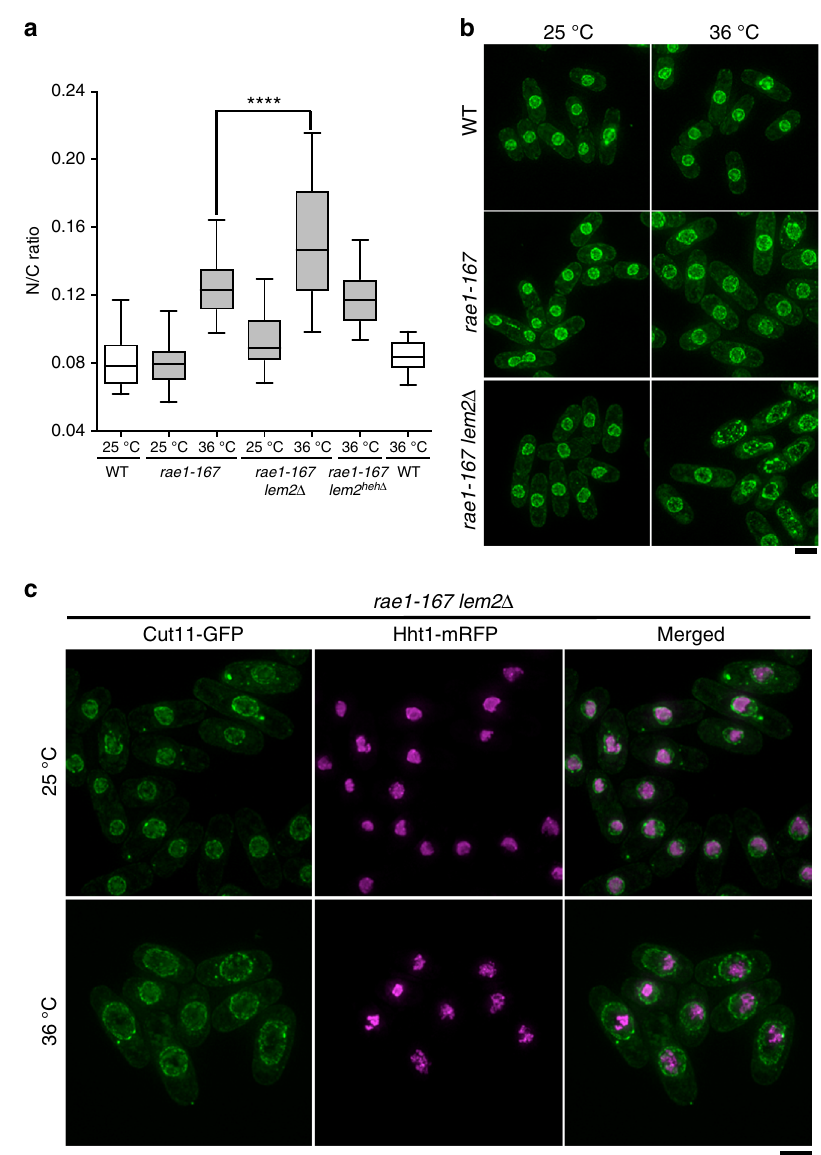
Fig. 1 Lem2 restricts nuclear size enlargement independently of its chromatin-binding activity. a N/C ratio of wild type (WT), rae1-167 , rae1-167 lem2 Δ , and rae1-167 lem2 heh Δ cells grown at 25 °C then shifted to the indicated temperature for 4 h ( n > 30 cells). Two-tailed t- tests: **** P < 0.0001, rae1-167 (n = 64 cells) against rae1-167 lem2 Δ ( n = 35 cells), t = 4.299, degrees of freedom = 97; rae1-167 lem2 heh Δ (36 °C) ( n = 31 cells) against rae1-167 (36 °C) ( n = 64 cells), P = 0.0863, t = 1.741, degrees of freedom = 93. In lem2 heh Δ cells, the N-terminal helix-extension-helix chromatin-binding region of Lem2 is deleted. In box-and-whiskers diagrams, boxes indicate median and upper and lower quartile and whiskers indicate range of data. The corresponding dot plot is available in Supplementary Fig. 9a. b Images of the nuclear envelope (Cut11-GFP, green) of wild type (WT), rae1-167 and rae1-167 lem2 Δ cells grown at 25 °C then shifted to the indicated temperature for 4 h. Maximum intensity projections shown. Scale bar: 5 µ m. c Images of the nuclear envelope (Cut11- GFP, green) and chromatin (Hht1-mRFP, magenta) of rae1-167 lem2 Δ cells grown at 25 °C then shifted to the indicated temperature for 2 h. Maximum intensity projections shown. Scale bar: 5 µ